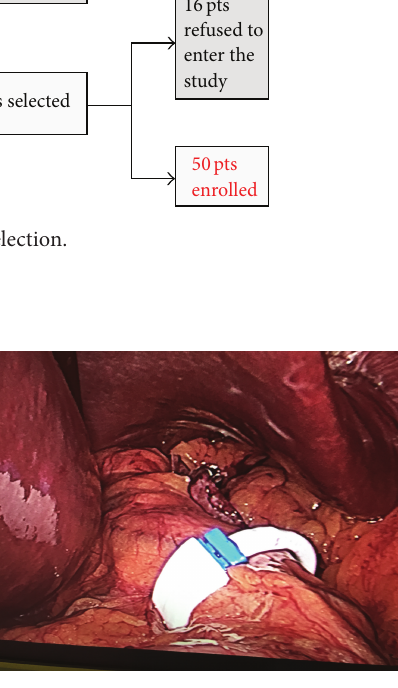
Figure 2: Laparoscopic Sleeve Gastrectomy with GaBP Ring Autolock (cid:3)